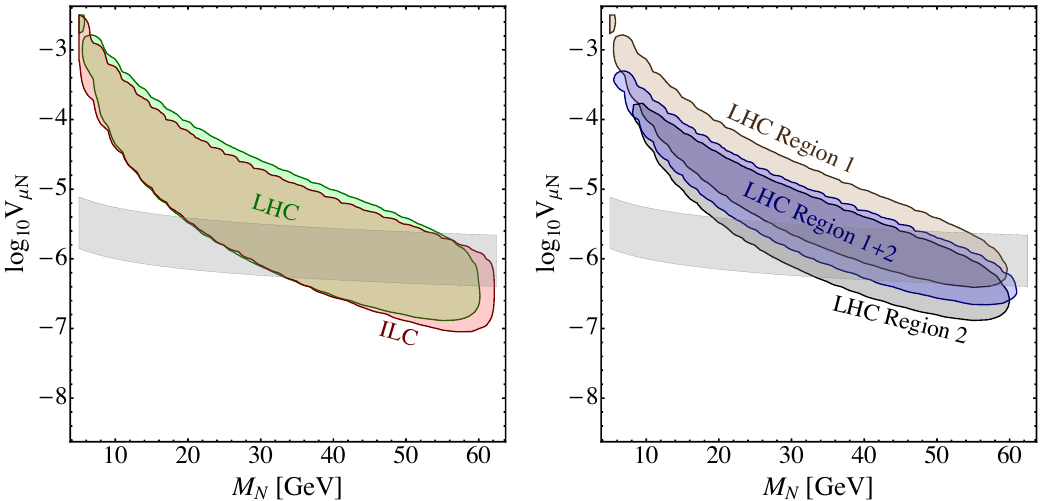
Figure 9 . Left: viable parameter space assuming the observation of two events each containing two displaced vertices, at the LHC and the ILC. Right: viable parameter space assuming the observation of two events in the simpli(cid:12)ed LHC detector, each containing two displaced vertices where: (i) both events are fully in Region 1, (ii) both events are fully in Region 2 or (iii) one event is fully in Region 1 and the other fully in Region 2. In both plots, the Higgs mixing sin (cid:11) is not (cid:12)xed but can vary up to its maximally allowed